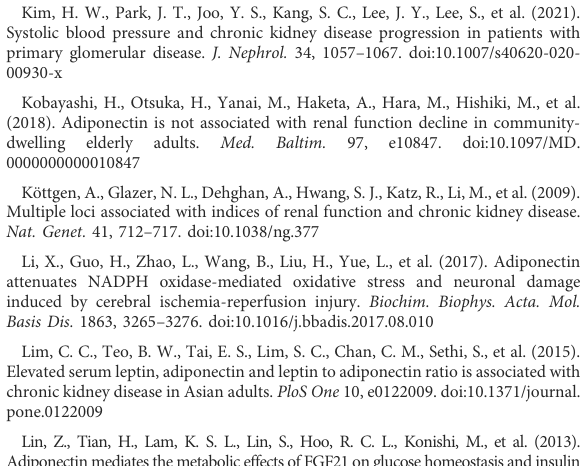
SUPPLEMENTARY FIGURE 1 The leave-one-out sensitivity analyses of adiponectin on CKD and eGFR. (A) The leave-one-out sensitivity analyses of adiponectin on CKD; (B) The leave-one-out sensitivity analyses of adiponectin on eGFR. SNP, single nucleotide polymorphism; eGFR, estimated glomerular fi ltration rate; CKD, chronic kidney disease; MR, Mendelian randomization. SUPPLEMENTARY FIGURE 2 The results of MR analyses of causal associations between each adiponectin SNP on CKD and eGFR. (A) The forest plot of each adiponectin SNP on CKD; (B) The forest plot of each adiponectin SNP on eGFR. SNP, single nucleotide polymorphism; IVW, Inverse variance weighted method; eGFR, estimated glomerular fi ltration rate; CKD, chronic kidney disease; MR, Mendelian randomization. SUPPLEMENTARY FIGURE 3 The funnel plot in SVMR. (A) The funnel plot of adiponectin on CKD; (B) The funnel plot of adiponectin on eGFR. IVW, Inverse variance weighted method; SVMR, single-variable Mendelian randomization. IV, instrumental variable; SE, standard error; MR, Mendelian randomization. SUPPLEMENTARY TABLE 1 SNPs used as genetic instruments in the Mendelian randomization analyses. SNPs, single nucleotide